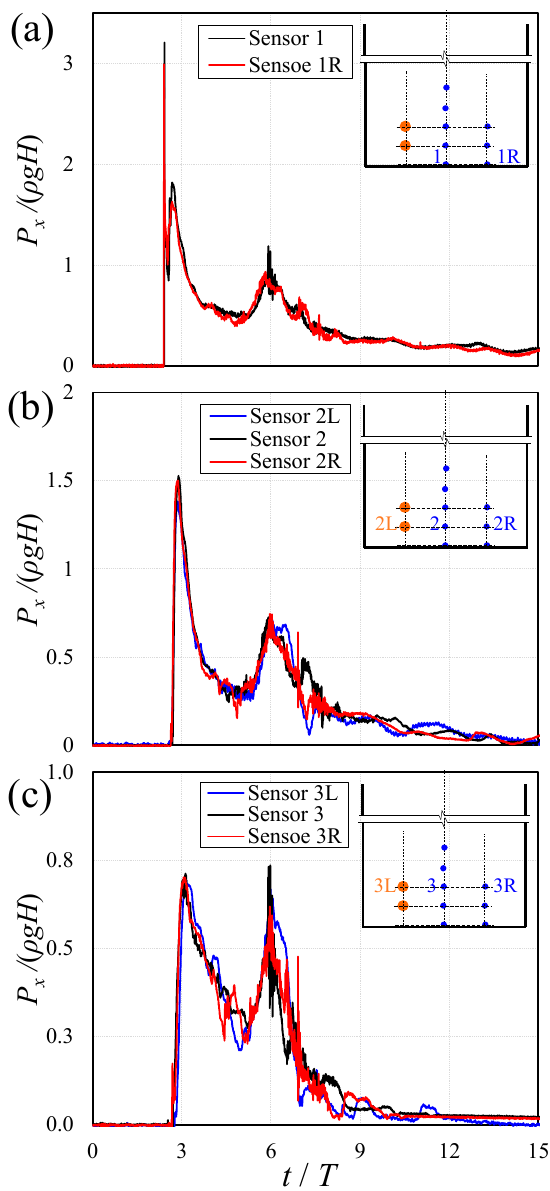
Figure 4. Time-history of non-dimensional horizontal pressure at different levels from the flume bed: ( a ) z = 2 mm, transducer 1 and 1R; ( b ) z = 35 mm, transducer 2, 2L, and 2R; ( c ) z = 70 mm, transducer 3, 3L, and 3R.